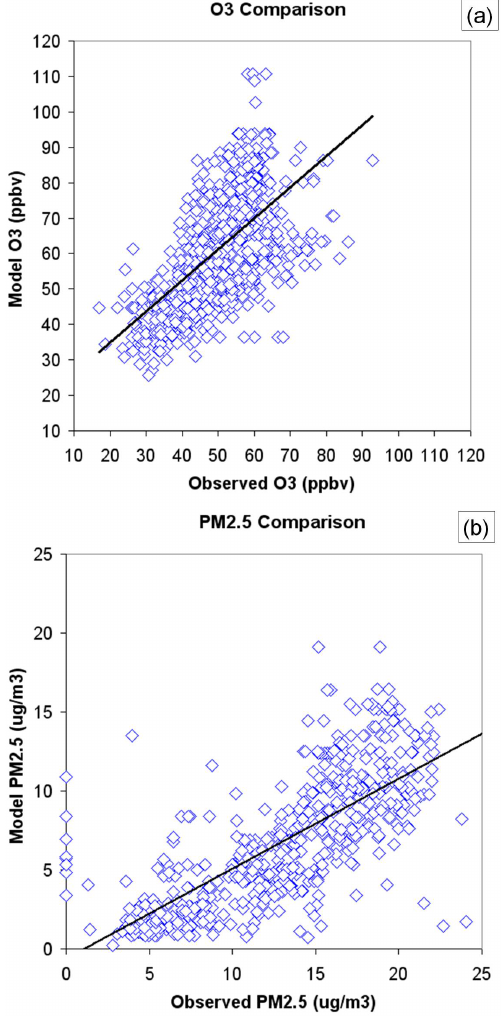
Fig. 3. Scatterplots of “Current” scenario comparisons to observa- tions. (a) Summer average maximum daily 8h average O 3 (ppbv), 915 stations. (b) Summer average daily average PM 2 . 5 (µgm − 3 ) , 565 stations. Statistical measures are given in Tables 4 and